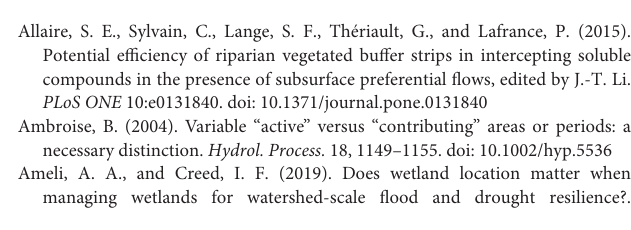
Supplementary Figure 1 | Top soils ( < 30cm) of DRIPs and non-DRIPs. The upper row shows a set of five DRIPs, characterized by a living Sphagnum moss layer over a peat layer. The bottom row shows five non-DRIPs of mostly decomposed organic matter, and root